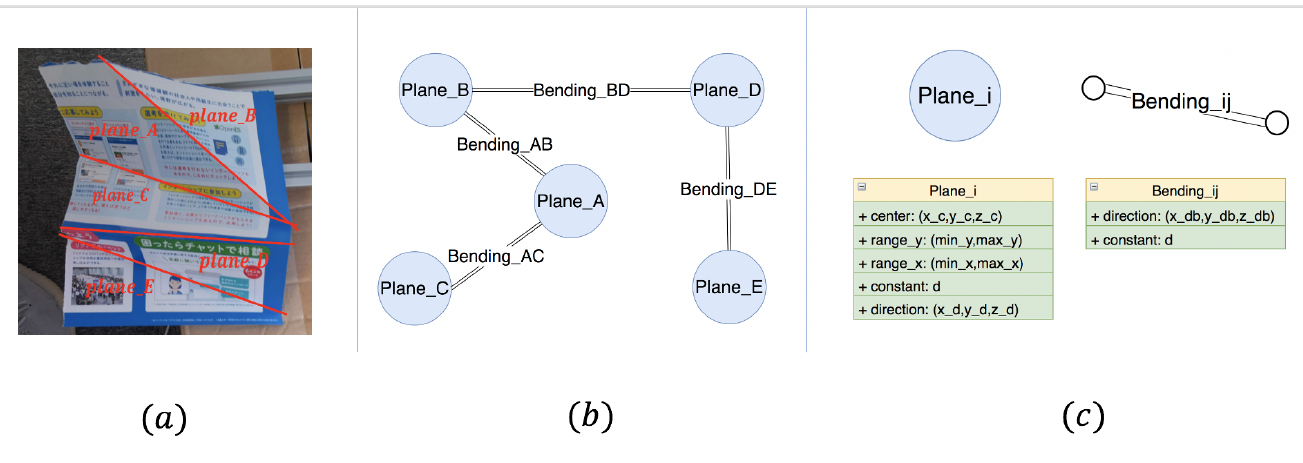
Figure 23. Data for reproduction: ( a ) Folded paper with four bending lines and five planes; ( b ) generated Graph r ; ( c ) node- edge